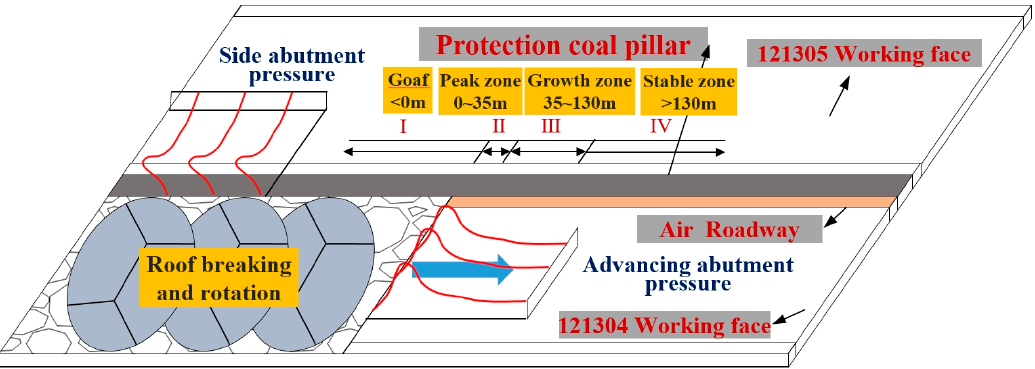
Figure 11. Stress distribution in mining process of working face.